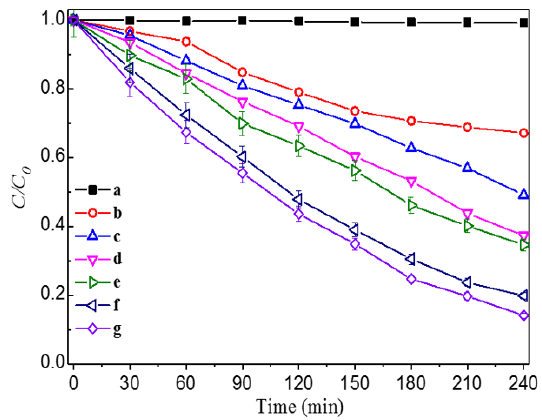
Figure 5. Degradation of sulfamethazine (SMT) on: ( a ) ZnO / Cu x O (5%) in the dark, ( b ) Cu x O, ( c ) ZnO / Cu x O (1%), ( d ) ZnO, ( e ) ZnO / Cu x O (2.5%), ( f ) ZnO / Cu x O (10%), and ( g ) ZnO / Cu x O (5%) under simulated solar light (310 nm–800 nm). Solution parameters: [catalyst] = 500 mg / L, [SMT] = 2.5 mg / L, initial pH 7.0, and solar light intensity 50.1 mW / cm 2 .